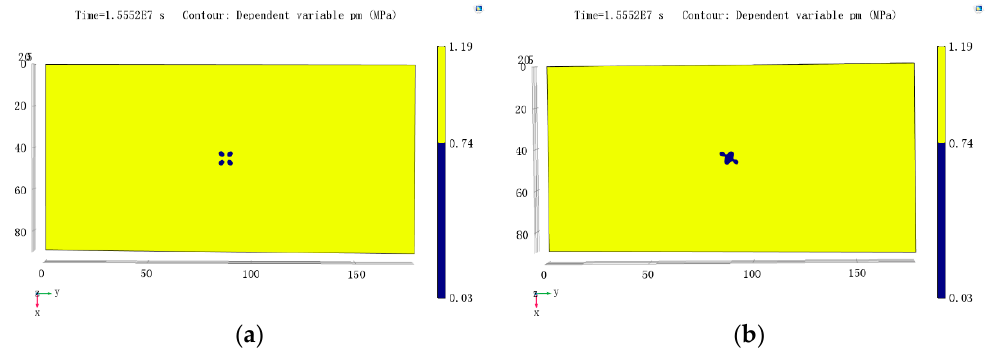
Figure 8. Areas with outburst risk eliminated on the inclined plane when boreholes are arranged in ( a ) a rectangle and ( b ) a rhombus at a spacing of 5 m. ( a ) a rectangle and ( b ) a rhombus at a spacing of 5